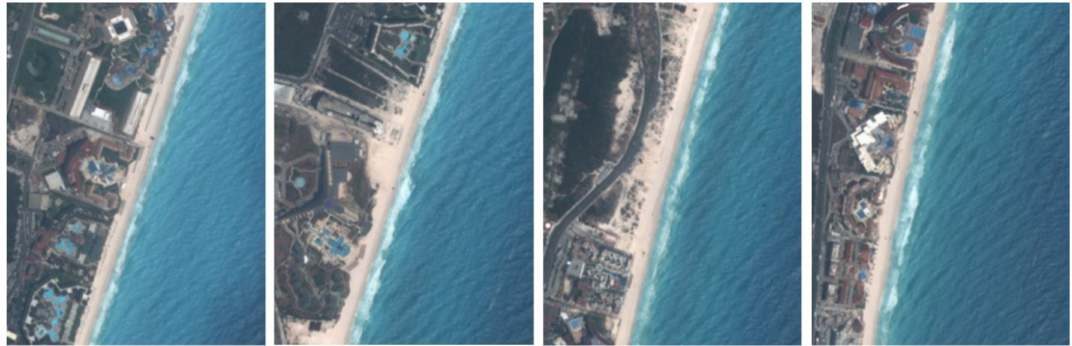
Figure 5. Aerial views (from north to south) of various segments of the central part of Cancun beach in May 2006; the immediate result obtained from the nourishment is evident.